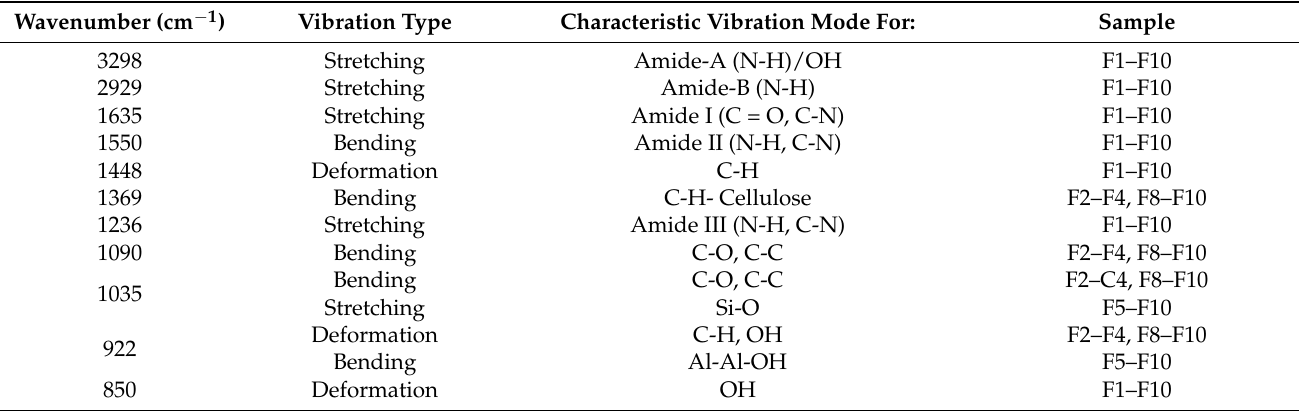
Table 2. Functional groups and possible vibration type detected by FTIR in the reinforced